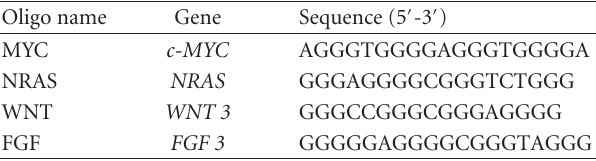
Table 1: Sequences of the G-quadruplex DNAs used in this study.